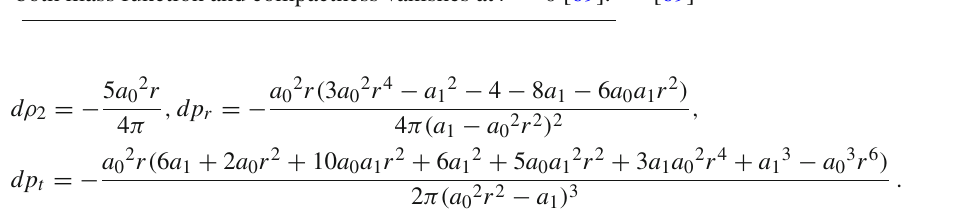
Fig. 11 Schematic plot of the radial coordinate r in the unit of km versus: a surface red-shift of Eq. (44), b mass and compactness using the stellar 4U1608–52 shows that solution (42) is a regular well-behaved because both mass function and compactness vanishes at r = 0